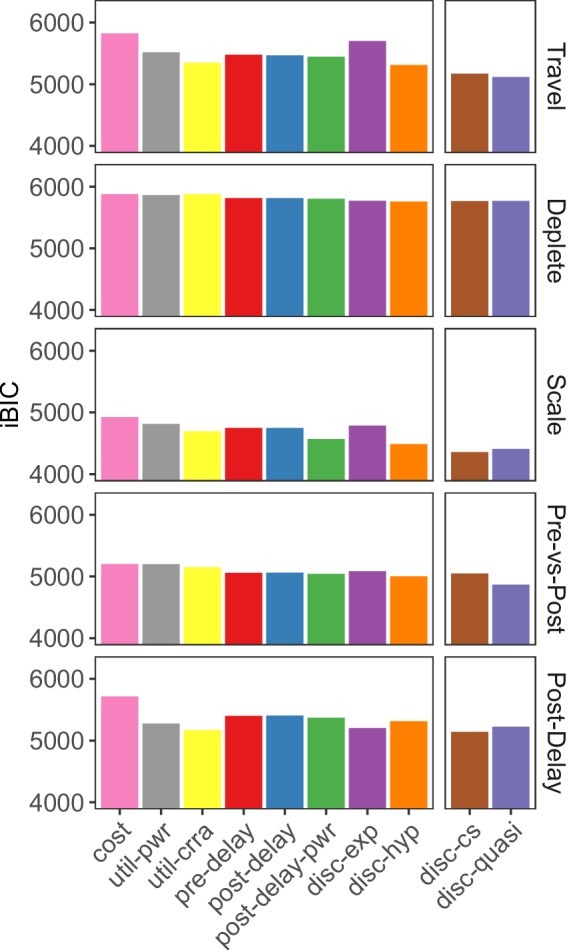
iBIC for each model for each foraging experiment.Cost = subjective cost model, util-pwr and util-crra = nonlinear reward utility with power and CRRA function respectively, pre-del = linear overestimation of pre-reward delays, post-del = linear underestimation of post-reward delays, post-del-pwr=underestimation of post-reward delays according to a power function, disc-exp = exponential discounting, disc-hyp = hyperbolic discounting, disc-cs = constant sensitivity discounting, disc-quasi = quasi hyperbolic discounting.